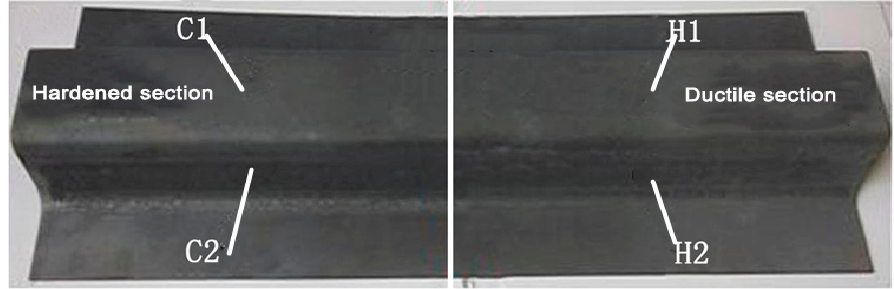
Figure 8. The two regions of the U-shaped part and the sampling position.